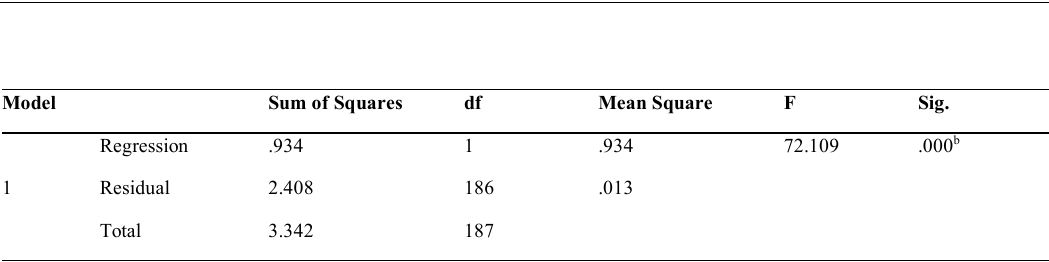
Table 3: ANOVA for Relationship between Management Commitment and Implementation of OHS Policies